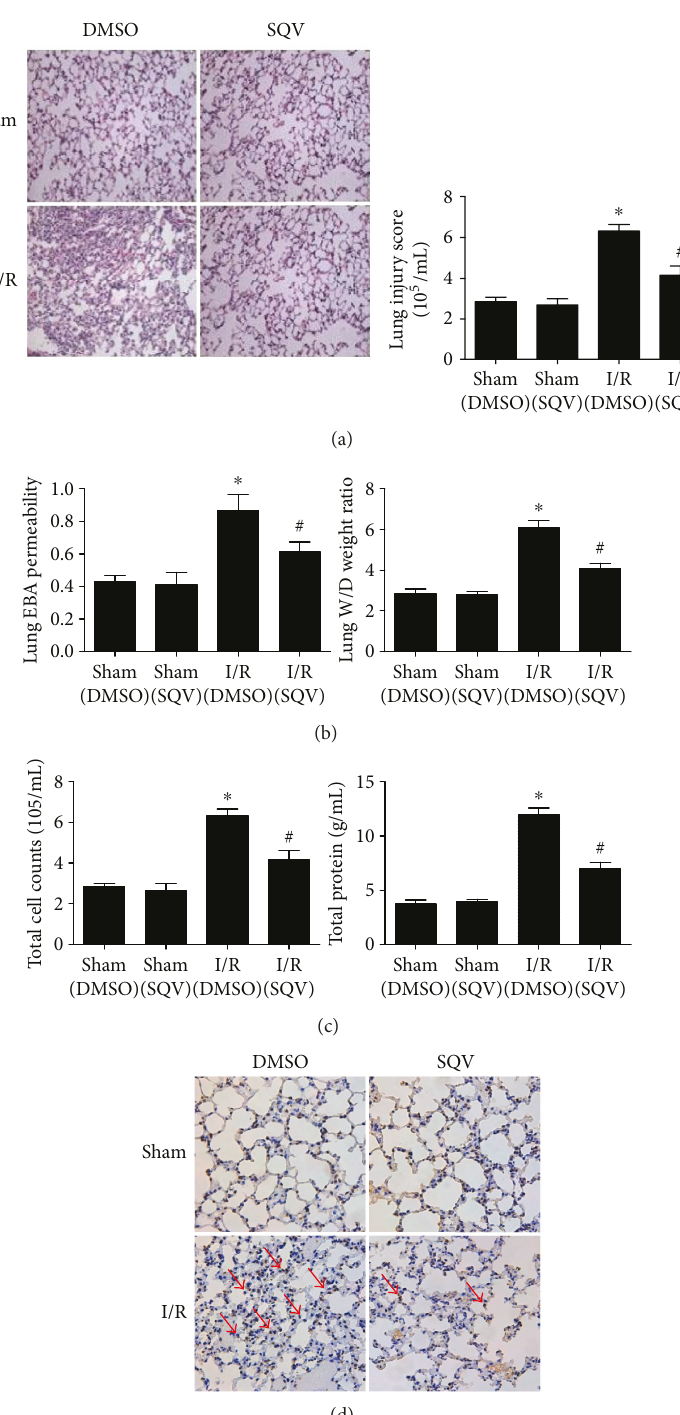
Figure 2: SQV could improve the lung injury induced by liver warm I/R. H&E staining and histological alterations of lung parenchyma were graded (a). Degrees of lung permeability and edema were re fl ected by EBA and W/D ratio (b). The total cell counts and protein concentration in BALF (c). Apoptotic assay (Tunel + ) was performed in the lung tissues of mice with or without SQV treatment after liver I/R (d). GraphPad values are presented as mean ± SEM. ∗ P < 0 05 versus the Sham group; # P < 0 05 compared to the liver warm I/R